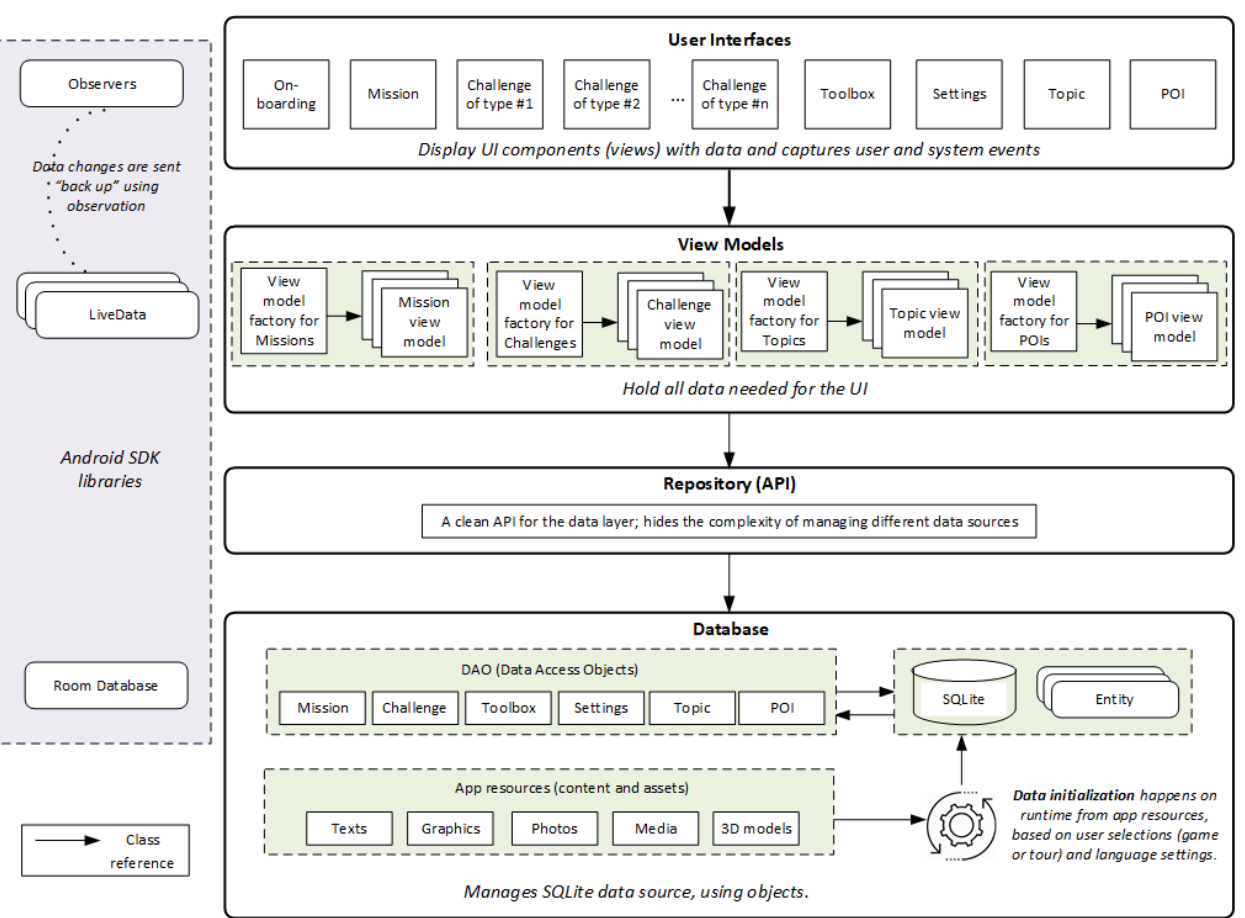
Figure 6. A common software architecture for mobile games, based on Android Architecture Components.